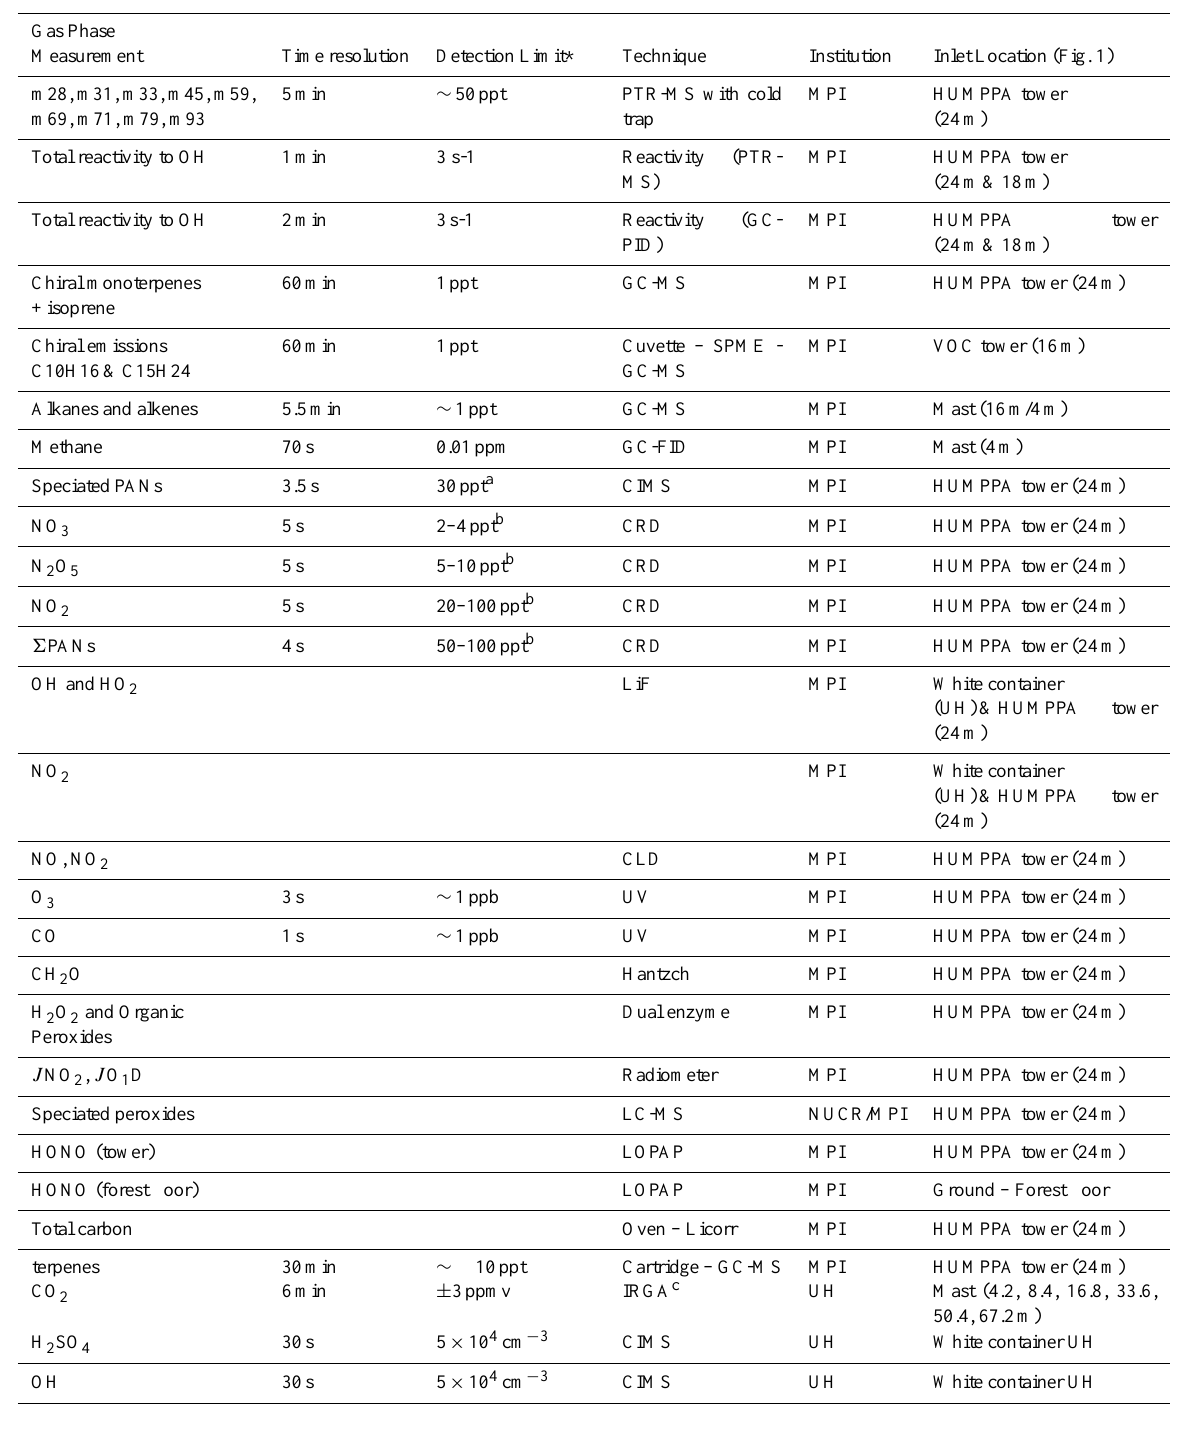
Table 1. The measurements made during the HUMPPA-COPEC intensive are tabulated alongside, the instrument type, time resolution, detection limit, responsible institute and location of the inlet (see also Fig.